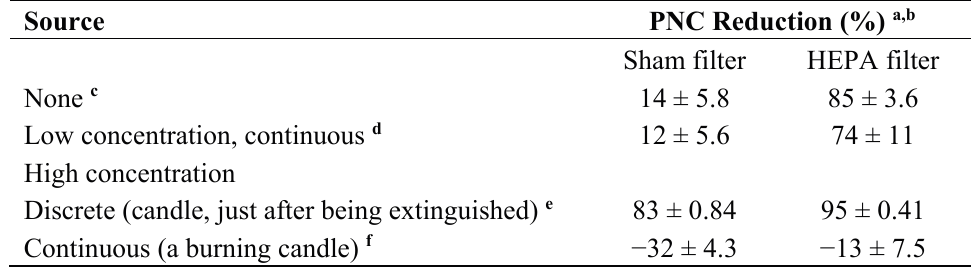
Table A1. Results of filtration experiments in an unoccupied furnished